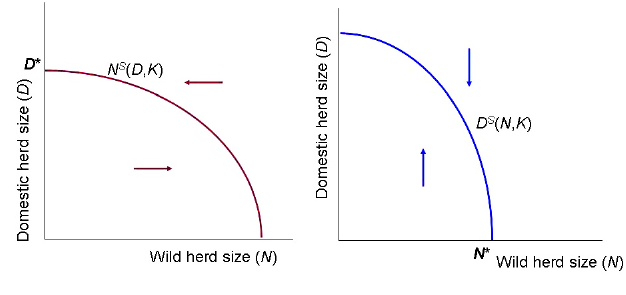
Fig. 8. More complex density-dependent models of interaction: domestic herds in competition with wild herds. Solid line shows stable population level for domestic herds given wild herd size. Arrows show direction of movement for population levels not on the line.